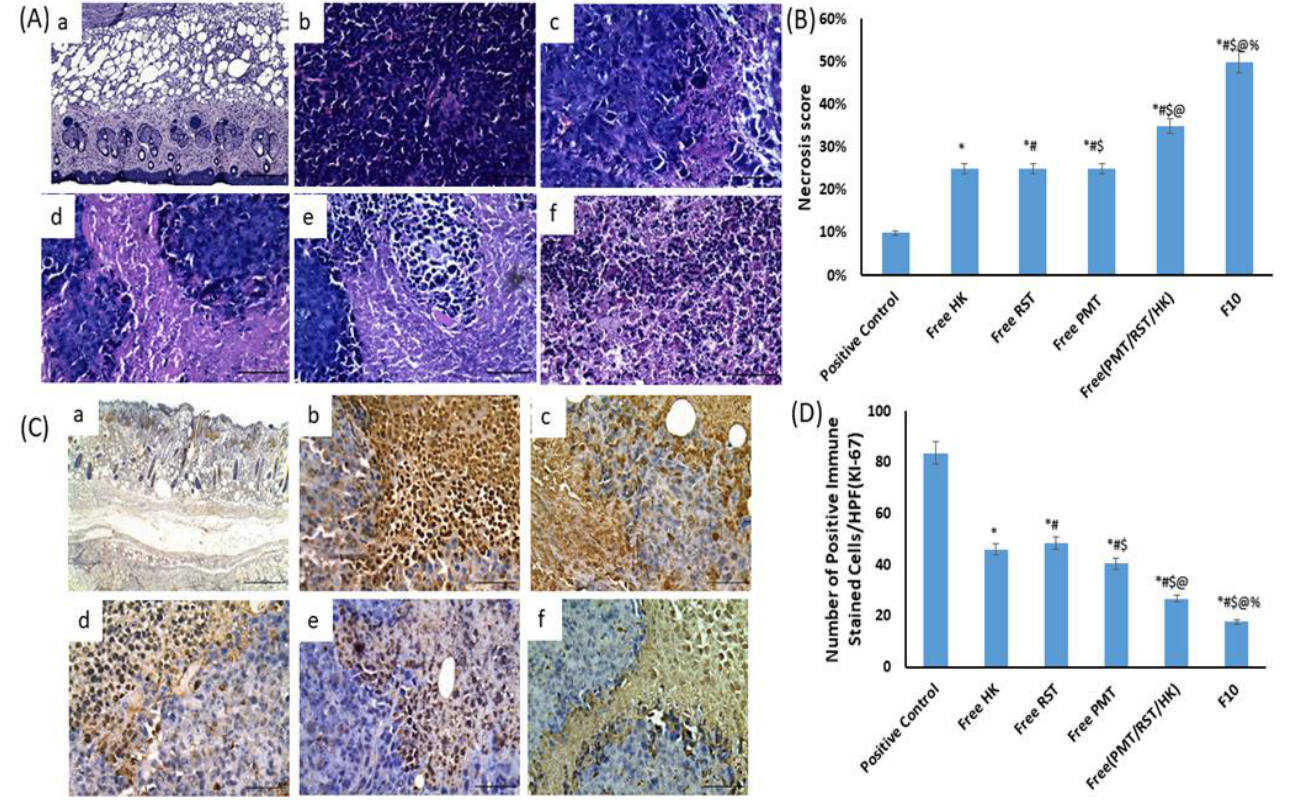
Figure 9. ( A ) Staining of H and E of EAT tissues of ( a ) positive control group, ( b ) free HK, ( c ) free RST, ( d ) free PMT, ( e ) free (HK/RST/PMT) combination therapy and ( f ) crosslinked HK-loaded